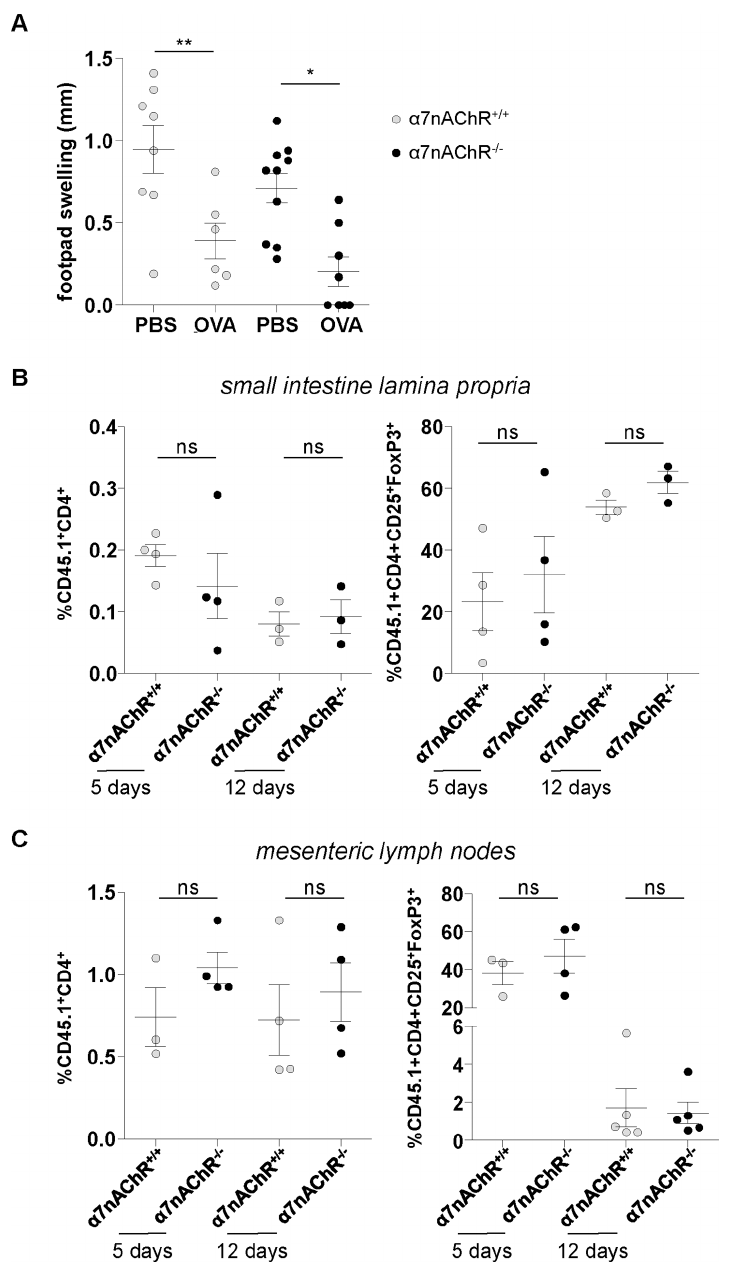
Figure 4. Oral tolerance and antigen-specific regulatory T cell induction are